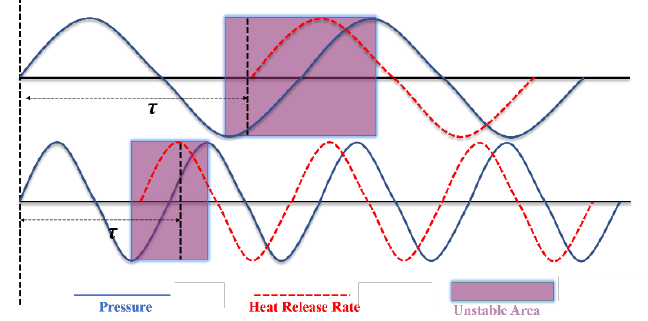
Figure 17. Schematic diagram of the influence of lag time on oscillation mode.